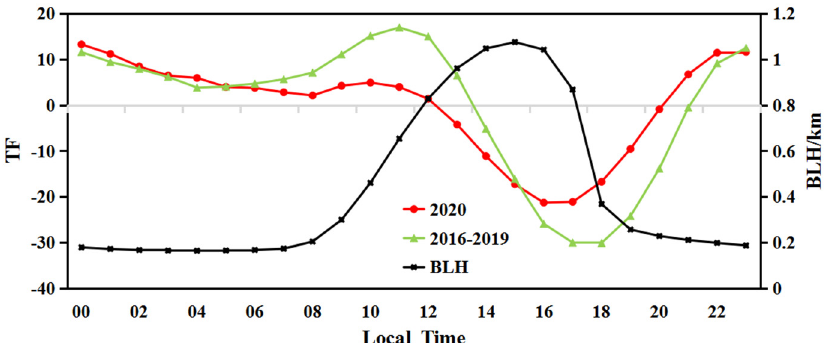
Figure 3. Diurnal variations of the first mode time factor of PM 2.5 EOF decomposition and the boundary layer height in Hubei Province. (The black line is the boundary layer height curve, the green dotted line is the daily change in the first mode time coefficient from 2016 to 2019, and the red dotted line is the daily change of the first mode time coefficient in 2020).